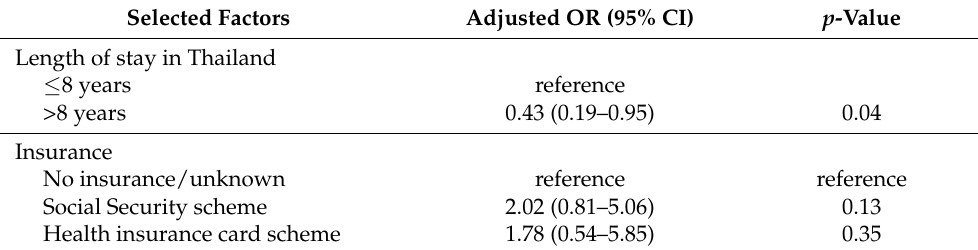
Table 5. Multivariate analysis on the awareness of public health measures during